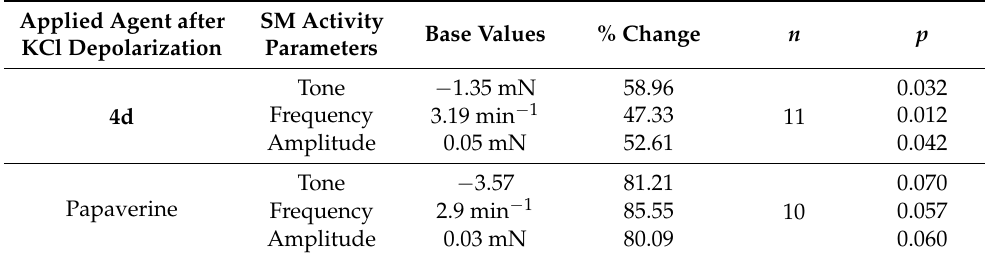
Table 1. Changes in the parameters of the spontaneous CA of SMPs when exposed to 4d (5 × 10 − 5 mol/L) and papaverine (1 × 10 − 6 mol/L) in Krebs solution with 42 × 10 − 3 mol/L KCl. The comparison is between the respective tone, frequency, and amplitude of the CA under the action of 4d and papaverine in the base Krebs